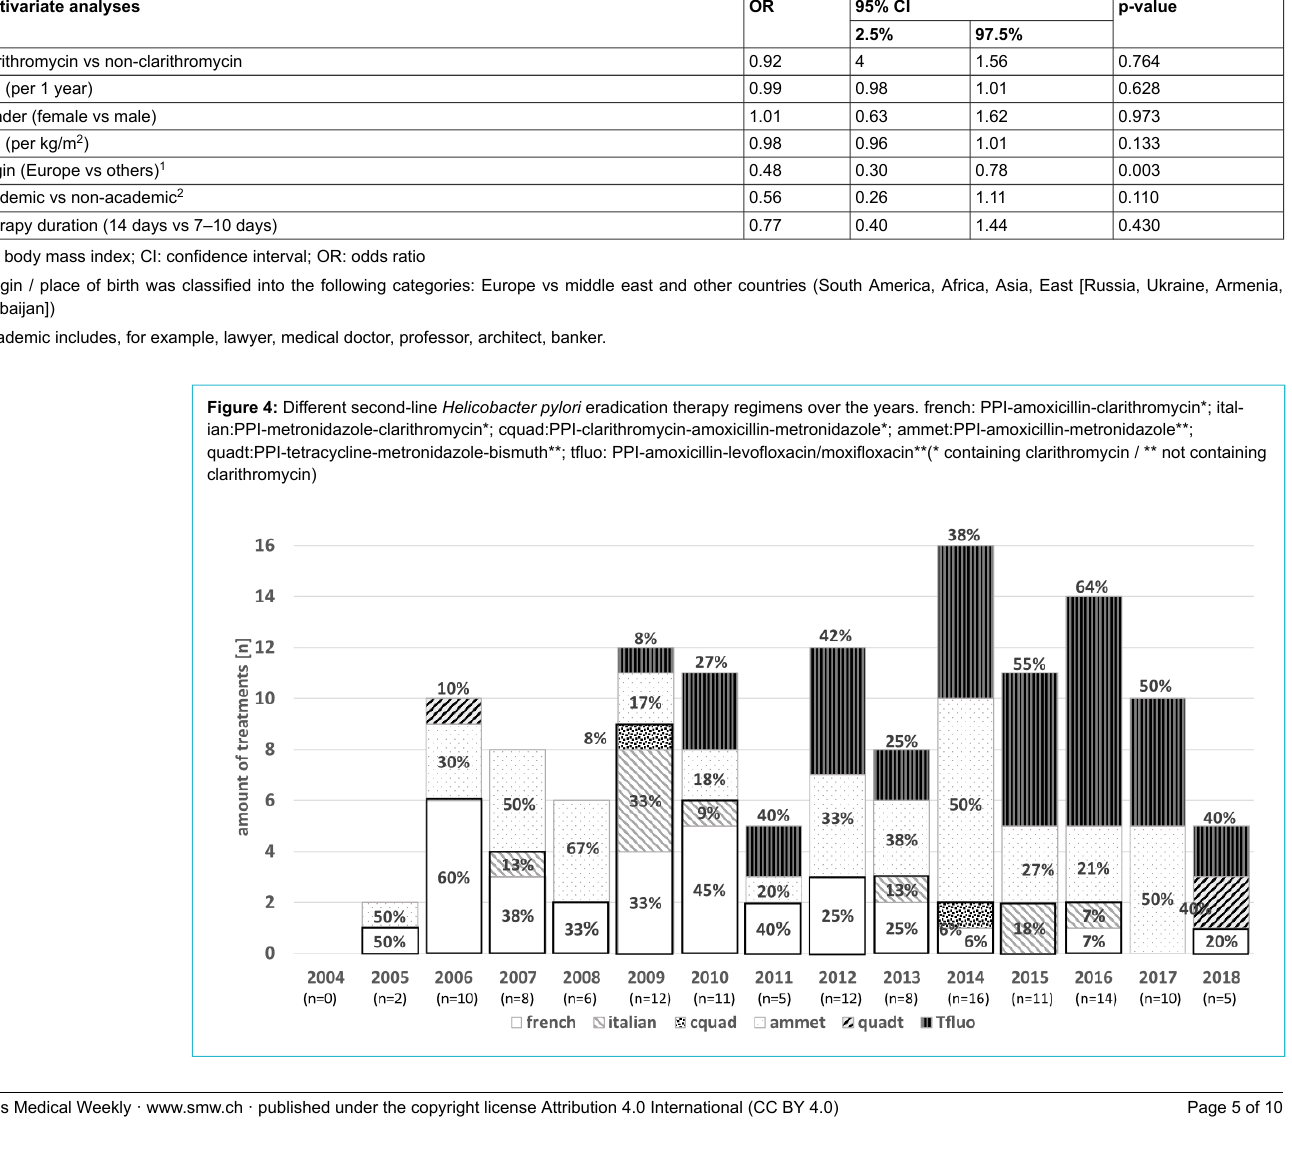
Table 3: Multivariate analyses of clinical factors related to Helicobacter pylori eradication success (smaller OR meaning less H. pylori after eradication therapy, i.e., better eradication suc- cess). Multivariate analyses